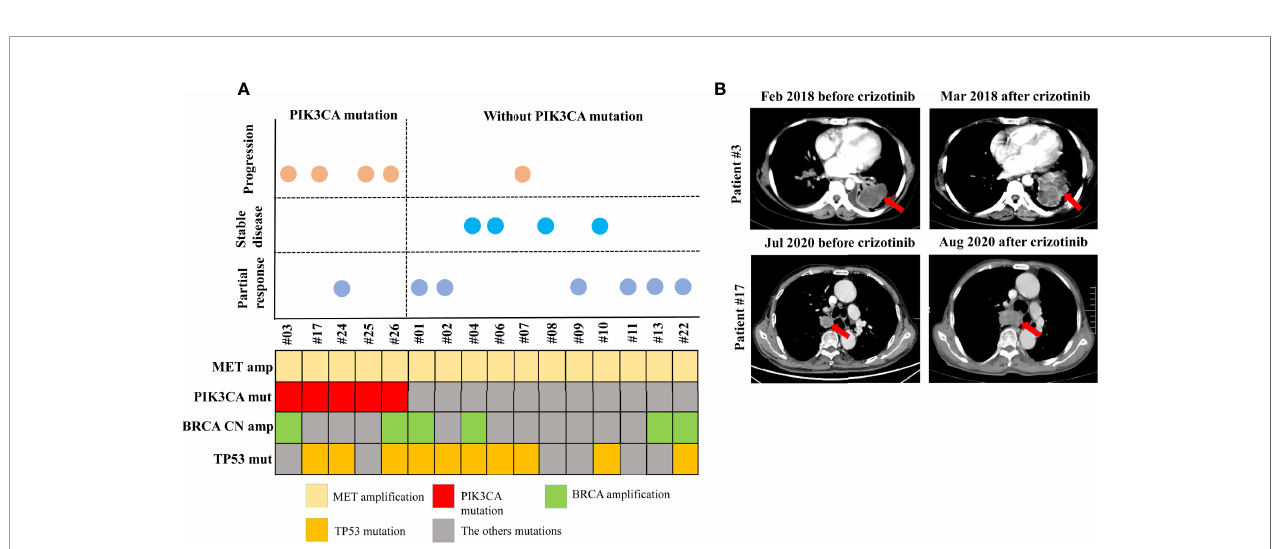
FIGURE 5 | Patients with a PIK3CA mutation in MET ampli fi cation cohort who received MET TKIs showed progressive disease. Schematic presentation of patients according to the response to MET TKI treatment, and to the presence or absence of a PIK3CA mutation (A) . Computed tomography scans of patient #3 and patient #17 showing disease progression after 1 month of MET TKI treatment (B)